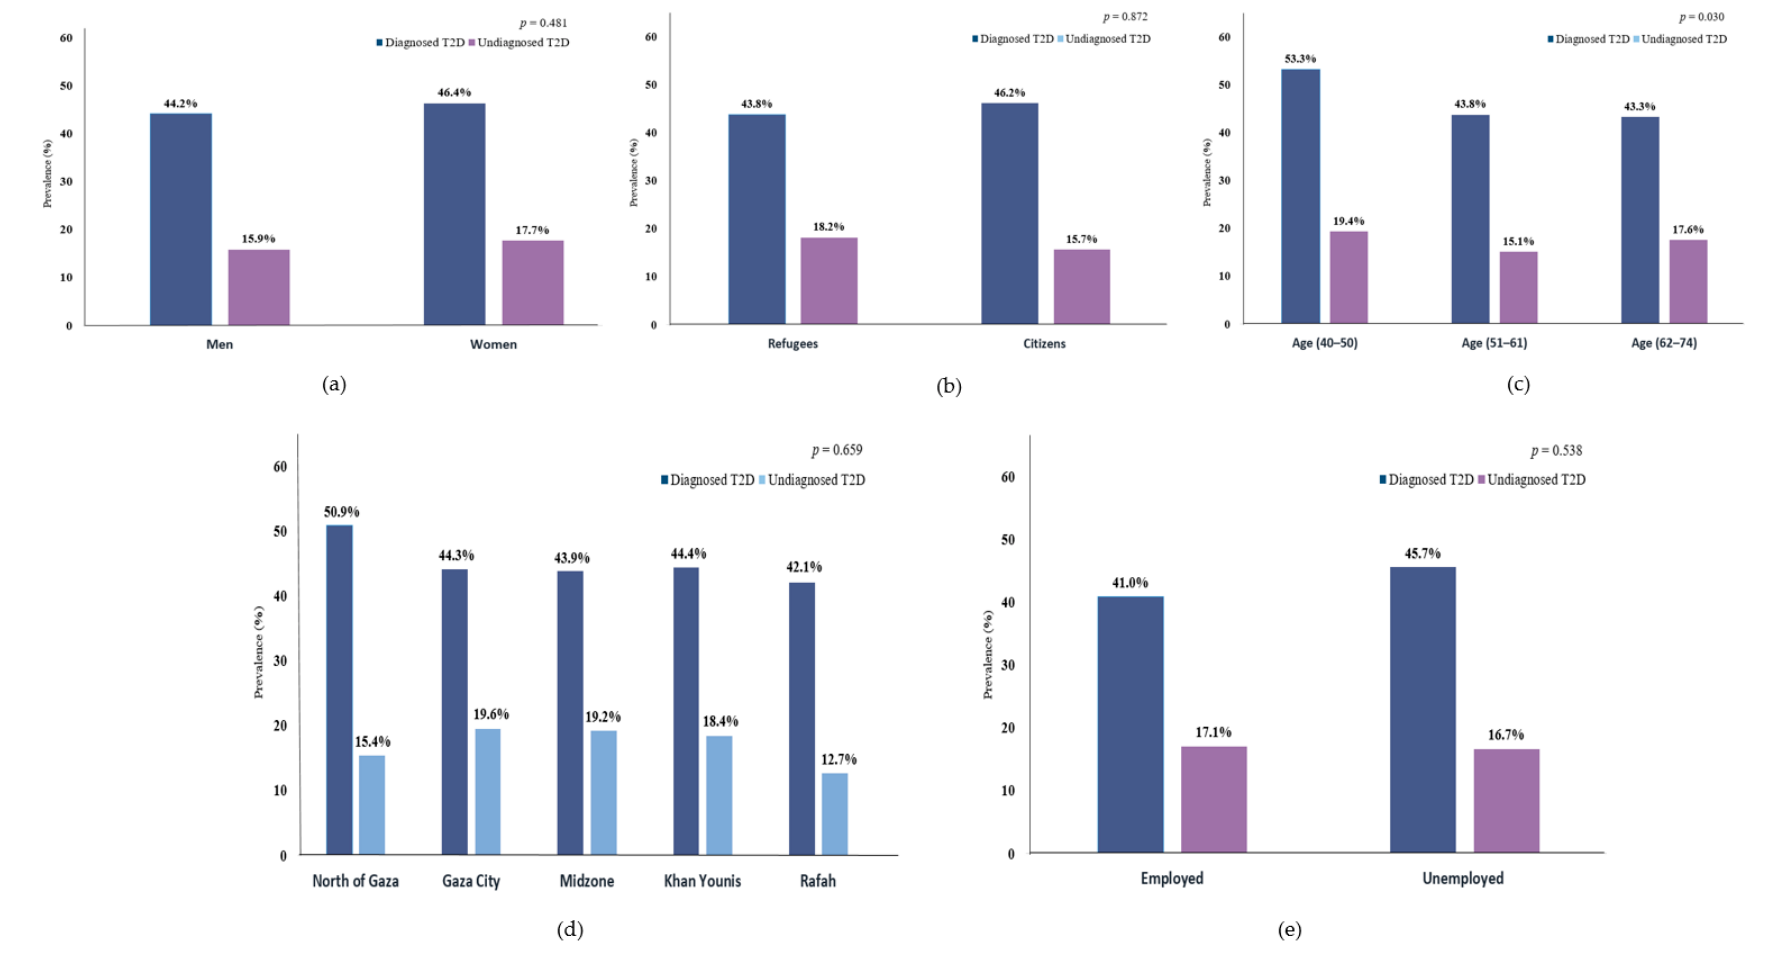
Figure 1. Prevalence of diagnosed and undiagnosed T2D by ( a ) sex, ( b ) population, ( c ) age groups, ( d ) region, and ( e ) working status.